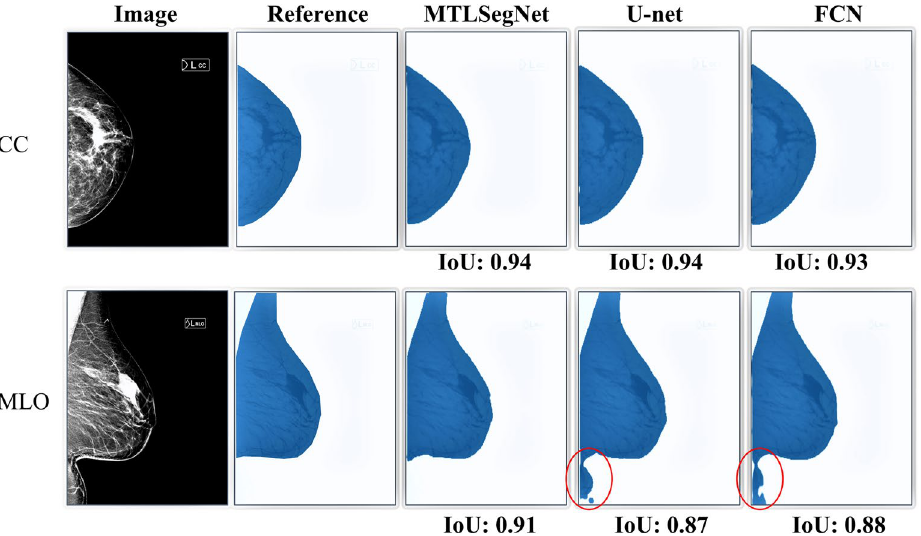
Figure 6. Breast-area segmentation outputs predicted by the MTLSegNet, U-net, and FCN networks on the KUH evaluation data. Red contours point to segmented regions of other tissue (in this case, abdominal tissues) predicted by the U-net and FCN models in the MLO-view.